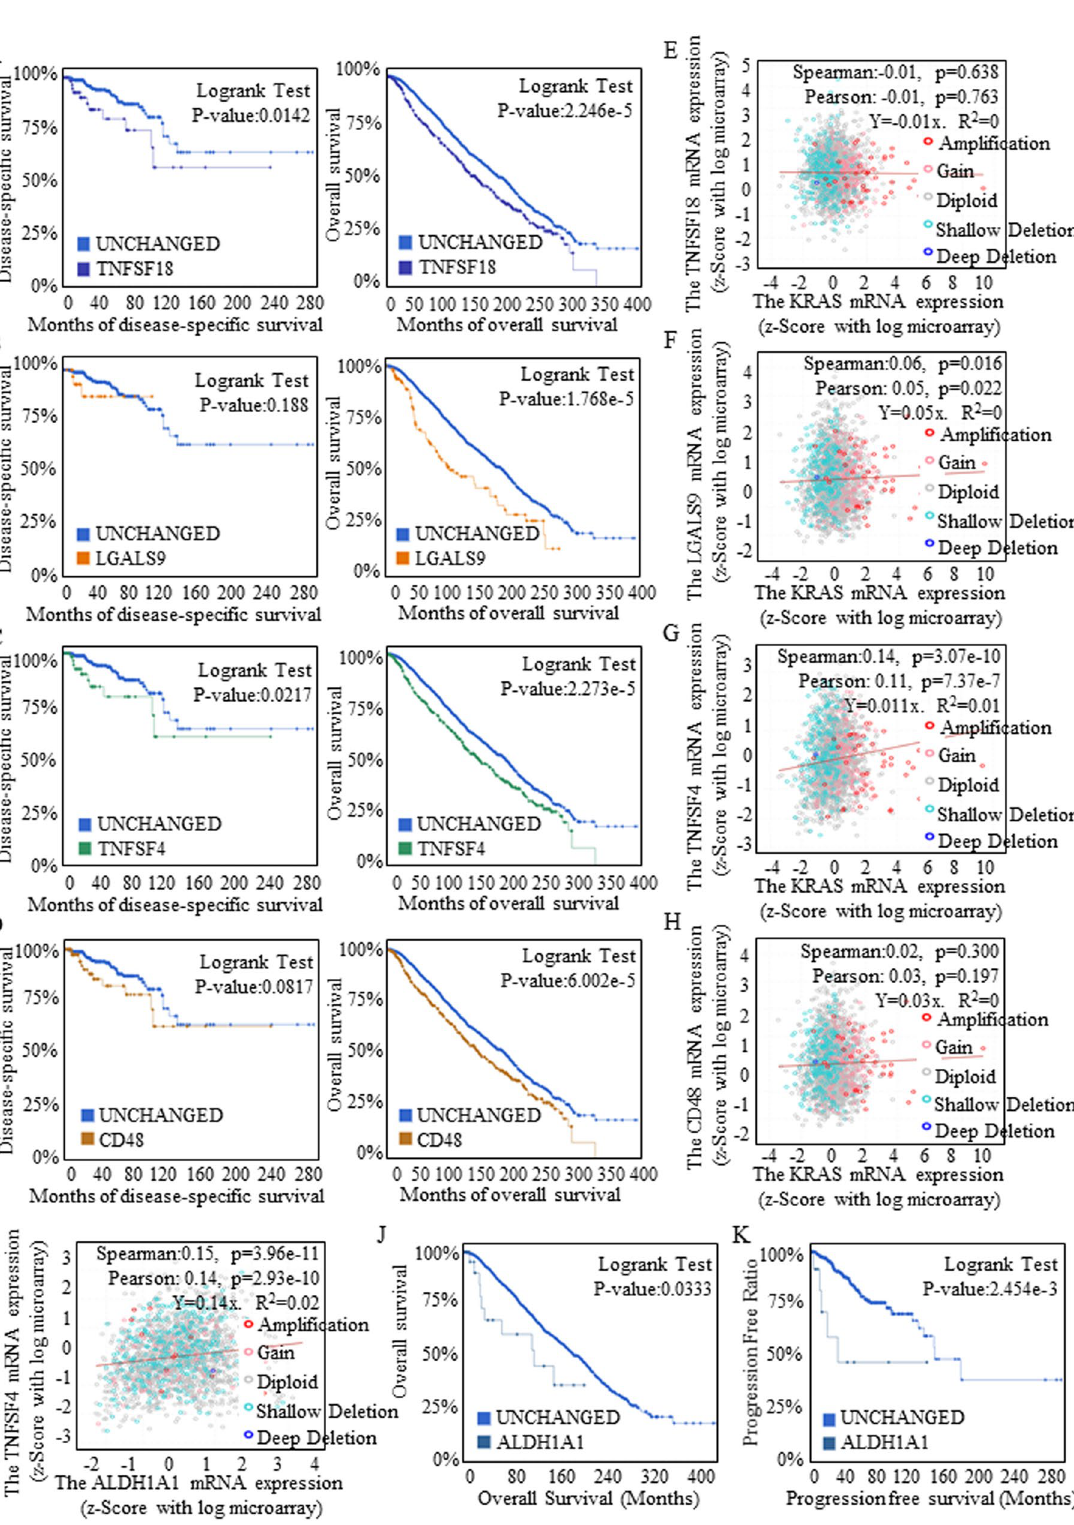
Figure 3. Clinical evaluations of potential therapeutic candidates. Data were acquired from the combined study cohorts of BREAST (METABRIC 2016), BREAST CANCER (MSK 2018), and BREAST INVASIVE CARCINOMA BREAST (TCGA PANCAN 2018). The clinical significance of the cluster including TNFSF18 ( A ), LGALS9 ( B ), TNFSF4 ( C ) and CD48 ( D ) was analyzed for the value of these molecules as immunotherapeutic targets. The correlations between KRAS and TNFSF18 ( E ), LGALS9 ( F ), TNFSF4 ( G ) or CD48 ( H ) were analyzed, and the positive correlation between TNFSF4 and KRAS strongly suggested the prospective therapeutic effects of using TNFSF4 as target for manipulation or blockade. ( I ) A close correlation between TNFSF4 and ALDH1A1 expression was identified. Stem cells with a positive ALDH1A1 phenotype had a shorter survival time ( J ) and shorter progression-free time ( K